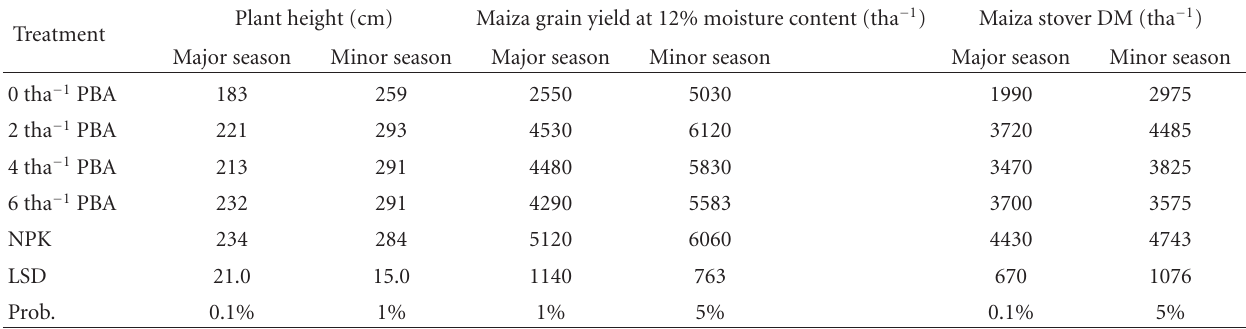
Table 5: E ff ect of PBA and NPK fertilizer on growth and yield of maize for the major and minor rainy season plantings.